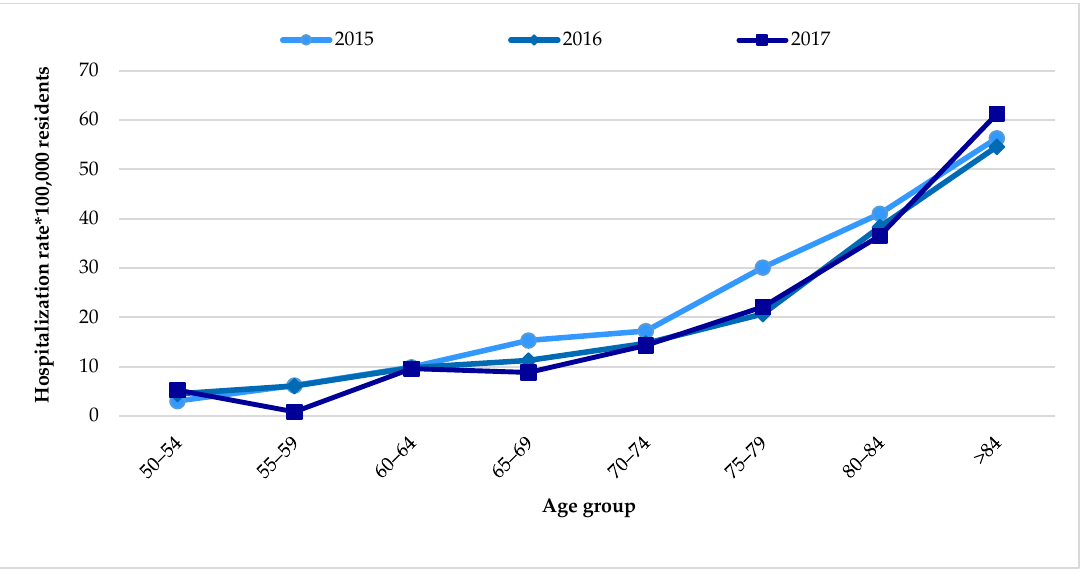
Figure 1. Herpes Zoster (HZ) hospitalization rate per 100,000 residents stratified by age group; years 2015 – 2017.